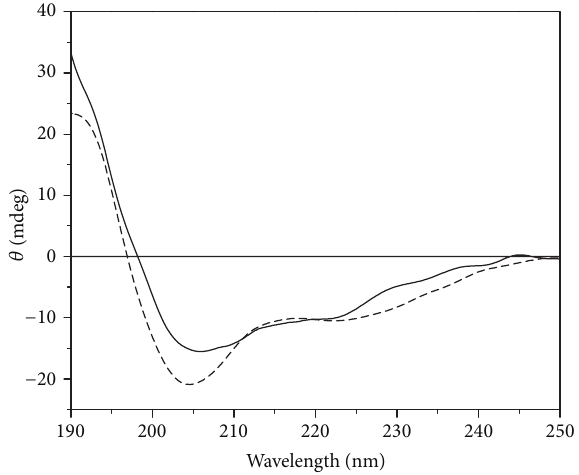
Figure 5: Different CD spectrum of GST-ZNF191(243-368) and GST. Solid line is CD spectrum of ZNF191(243-368) and dash line is different CD spectrum of GST-ZNF191(243-368) and GST.